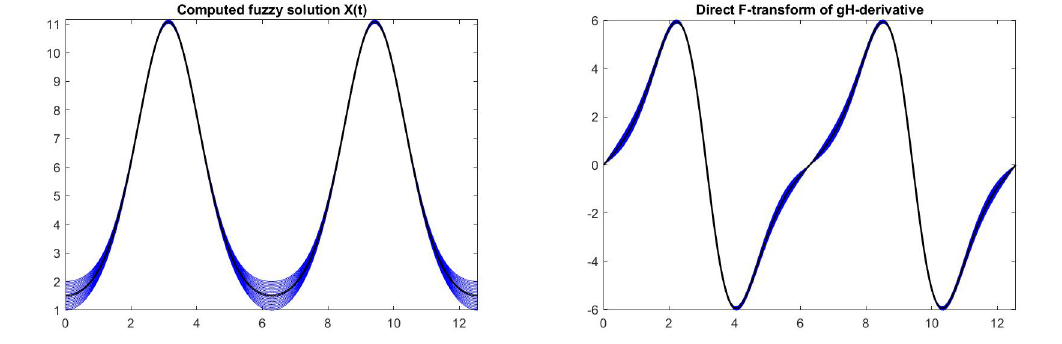
Figure 16. Problem FDE2, Meth = 2: gH-differentiable solution ( left ) and its gH-derivative ( right ). There are three switching points, in the same position for all α